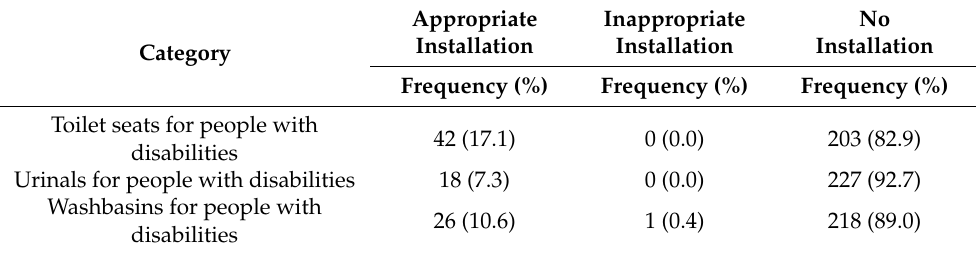
Table 5. Installation state of sanitary facilities.